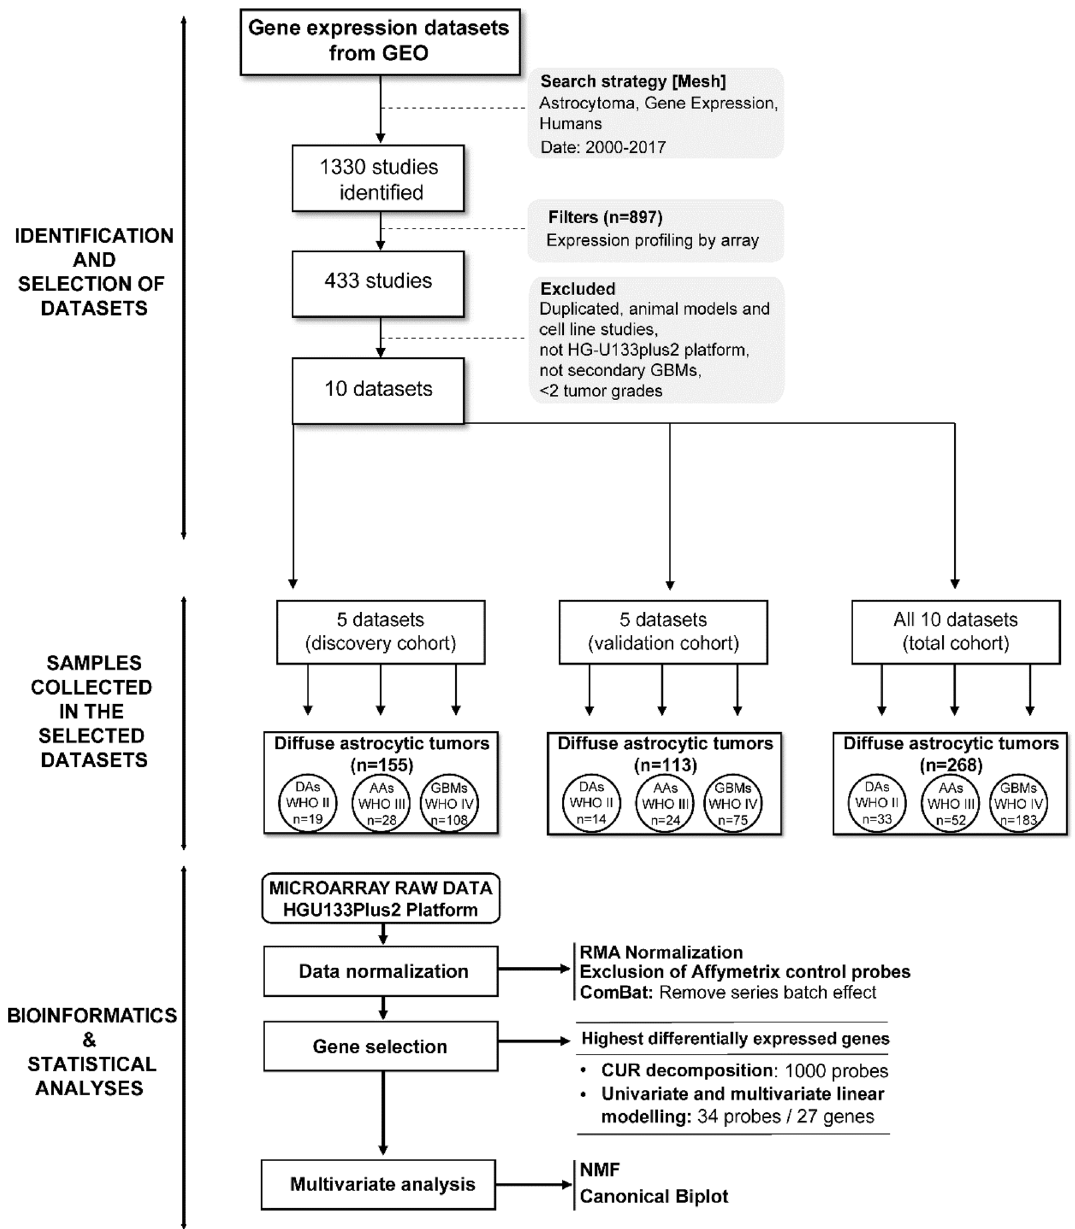
Figure 4. Flowchart summarizing sample data collection, selection criteria and steps, and the gene expression bioinformatics pipeline used in this study. Based on the filters and exclusion criteria, a total of 155 plus 113 diffuse astrocytic tumors grouped into 3 diffuse astrocytic tumor subtypes were included in the discovery and validation cohorts, respectively. For data analysis, individual variability was first removed by applying RMA, followed by the ComBat method. Then, those probes showing the highest differences among the groups of tumors were selected via CUR decomposition and pairwise comparisons. Based on the selected gene probes and multivariate analysis via nonnegative matrix factorization and canonical biplot graphical representation, those genes providing the highest discrimination among the distinct subtypes of astrocytic gliomas were diffuse astrocytic gliomas consisting of 14 DA (12%), 24 AA (21%) and 75 GBM (67%). The two (discovery and validation) cohorts also showed a similar distribution per age (median of 60 vs 56 years, respectively; p = 0.591, by the Mann–Whitney U) and sex (male/female ratio of 1.94 and of 1.63, respectively; p = 0.705 by the Fisher exact test) for patients for whom data on these features were publicly available (108/155 and 64/113 had data on age and 47/155 and 79/113 patients had data on sex, respectively).